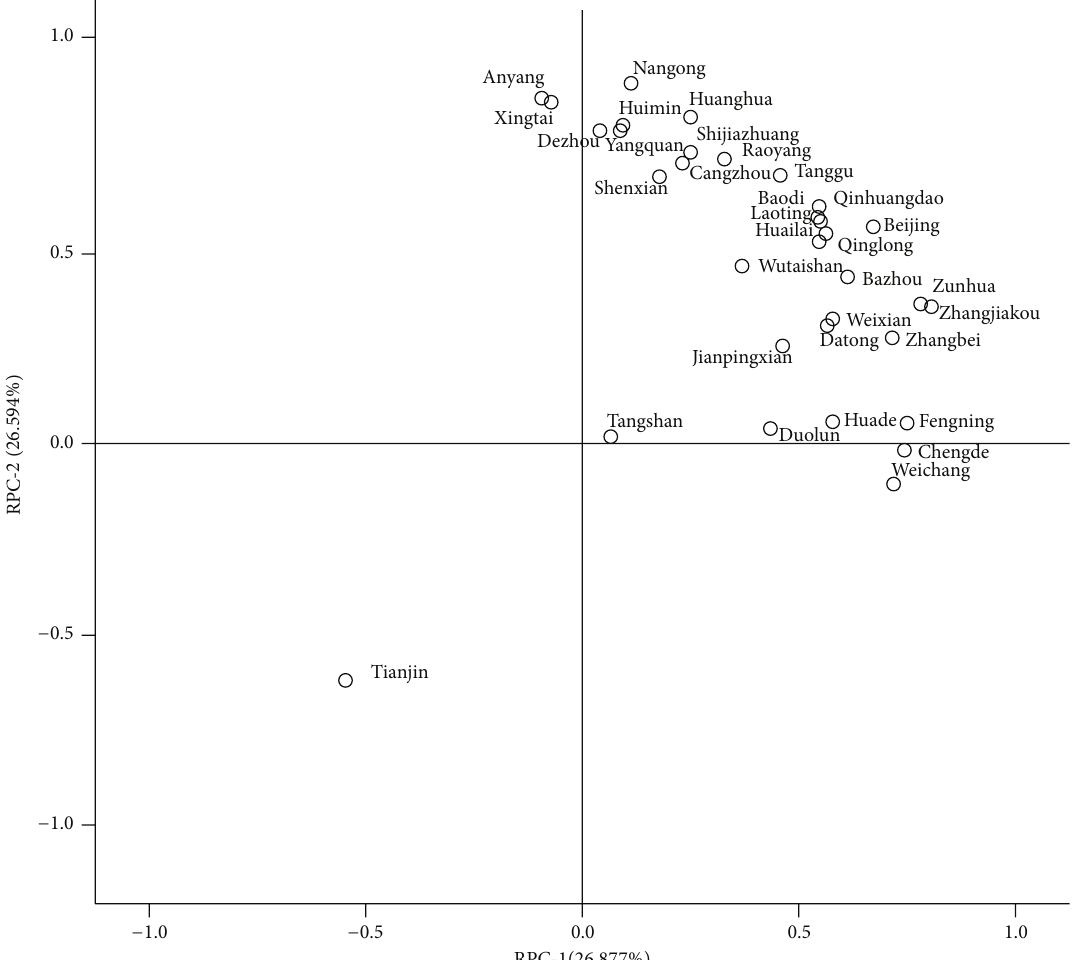
Figure 7: Scatter plot of the correlations between variables and principal components after varimax rotation for the RDI-12 series.